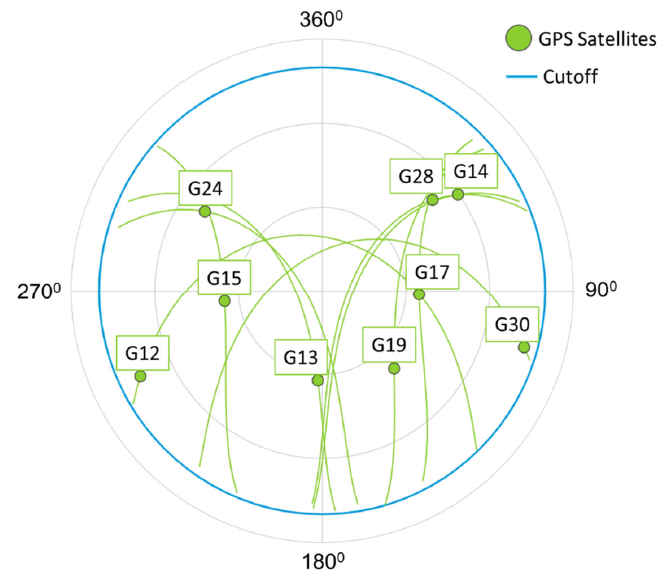
Figure 9. The satellite locations in the sky during the experiments.